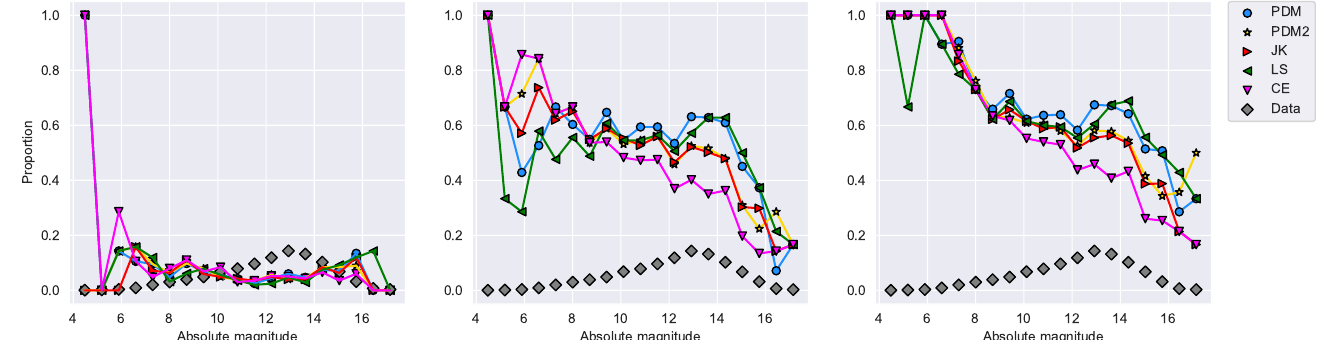
Figure 5. The comparison of different period finding algorithms considering the different absolute magnitudes for the step size defined in Equation (3) with A = 10. The criterion for comparison is the proportion of asteroids having a successful periodic recovery. From left to right, the three plots are for different δφ max = 85/50,850/50 and 8500/50. The gray diamonds indicate the proportion of asteroids at the corresponding absolute magnitude in our data